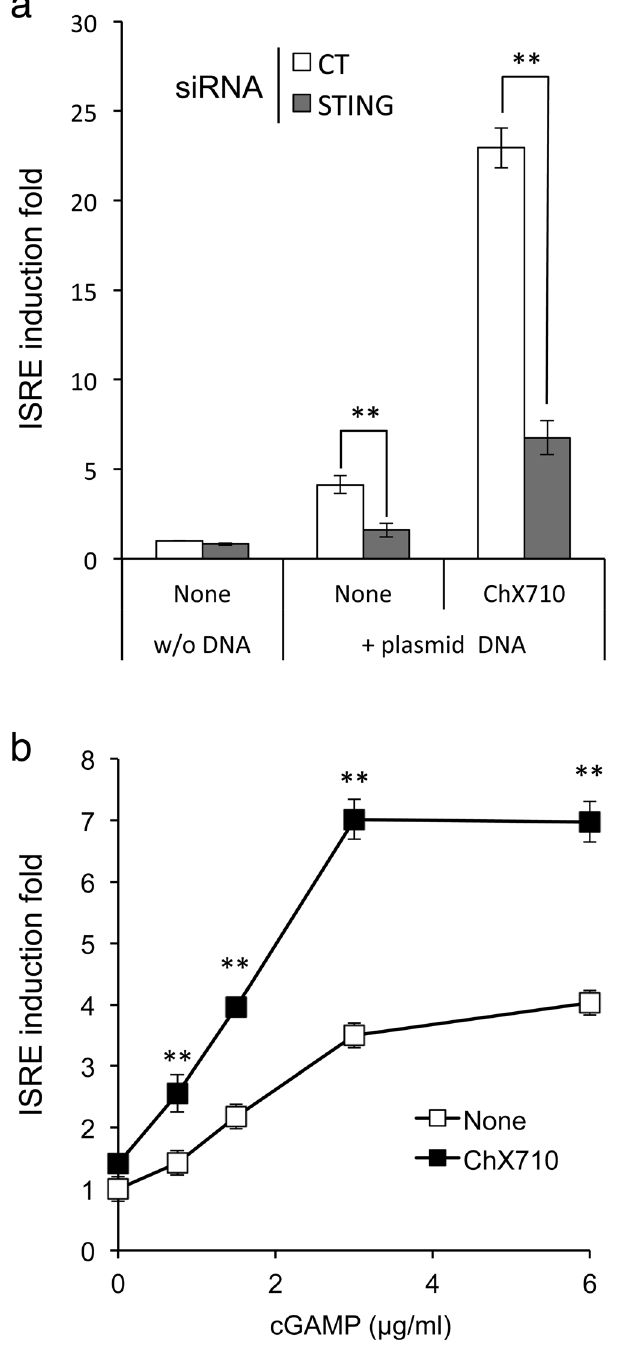
Figure 8. Synergistic ISRE induction by DNA transfection and ChX710 is STING dependent. ( a ) STING was silenced by siRNA transfection in ISRE-luciferase reporter cells. After 48 hours of cultures, cells were transfected with plasmid DNA (pCiNeo-3xFlag-GW) and stimulated with ChX710. After 24 hours of incubation, luciferase induction was determined. Data represent means ± SD of three independent experiments. ( b ) ISRE-luciferase reporter cells were treated with 2 ′ ,3 ′ -cGAMP at indicated concentrations with ChX710 (6 μ M) or DMSO alone. After 24 hours of incubation, luciferase induction was determined. Experiment was performed in duplicate, and data represent means ± SD. ** P < 0.01 corresponds to statistically significant differences as calculated by two- way ANOVA and Bonferroni’s post hoc